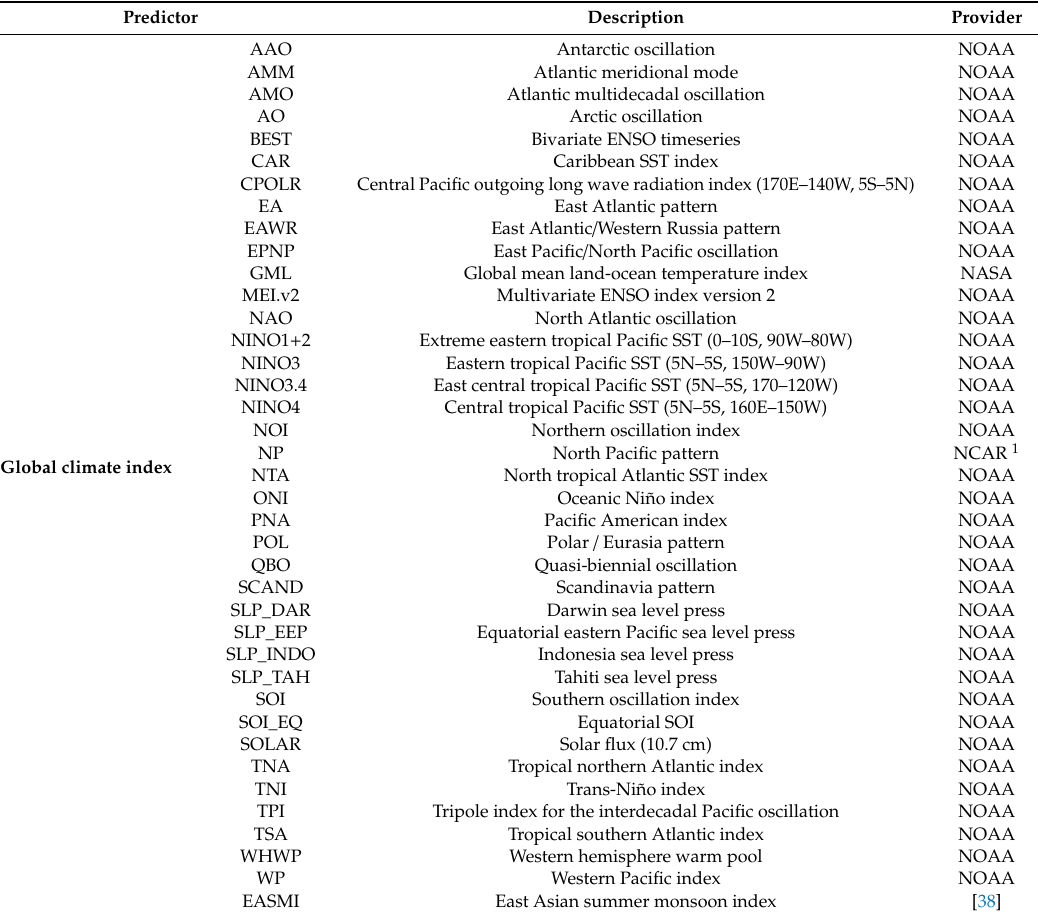
Table 2. Predictors used in this